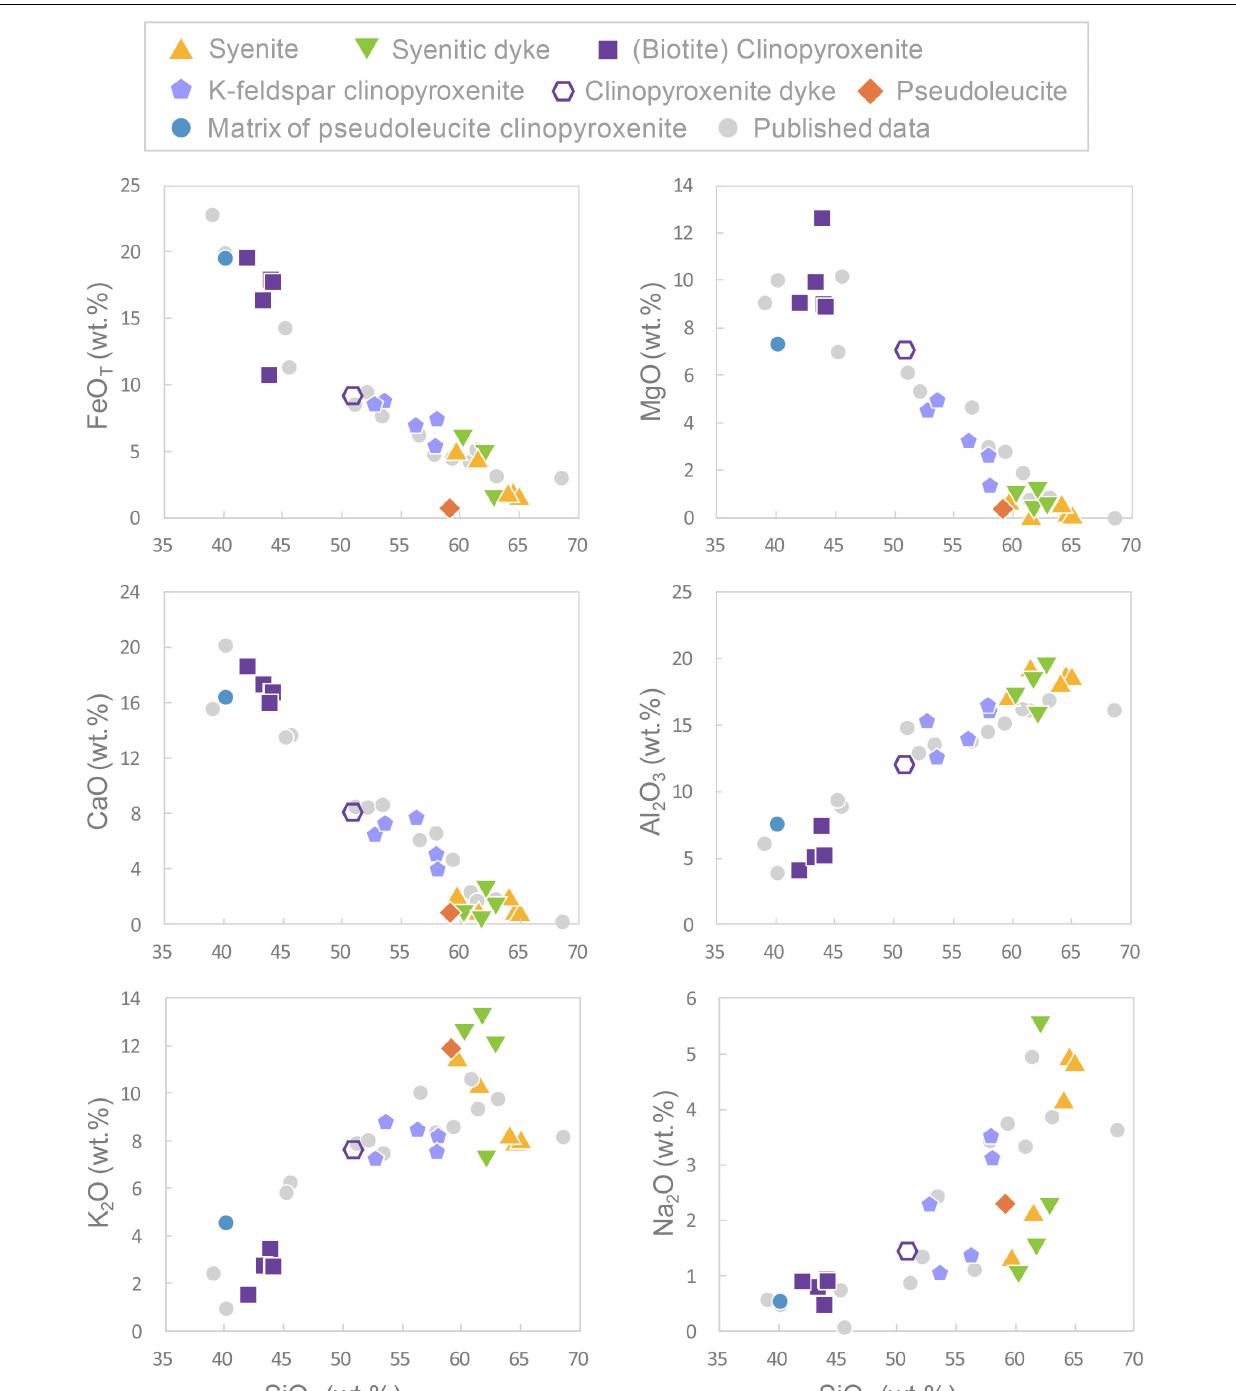
are almost pure orthoclase, showing restricted compositional variation of Or 86 . 2 − 95 . 0 Ab 4 . 8 − 13 . 8 An 0 . 0 − 0 . 3 ( Figure 11B ). For example, the compositions of K-feldspar in both of psudoleucite